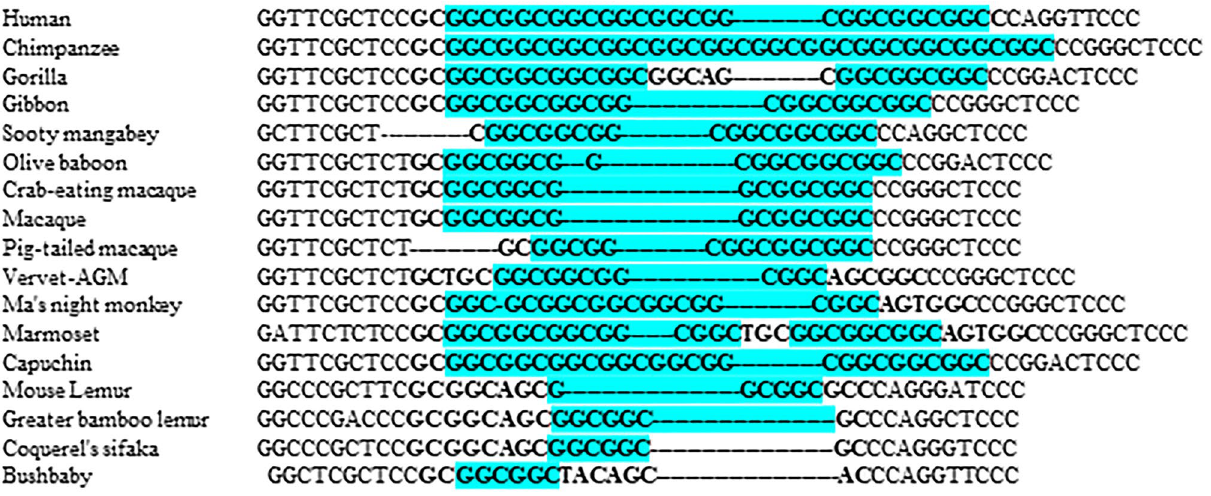
Figure 5. Sequence alignment of the SBF1 (GCC)-repeat across selected vertebrate species. The (GCC)-repeat expanded beyond 2-repeats in